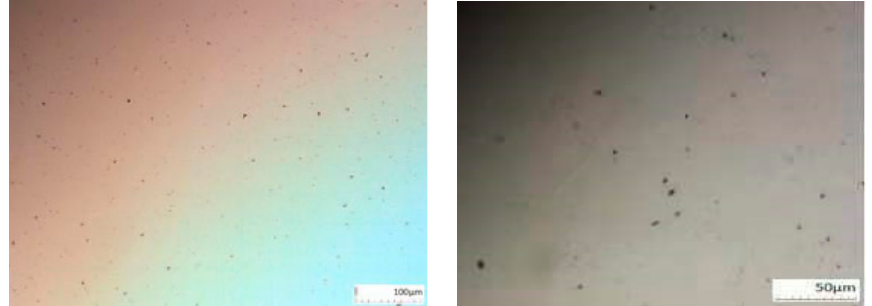
Figure 2. The images of prepared nanofluid samples under multifunctional stereomicroscope.